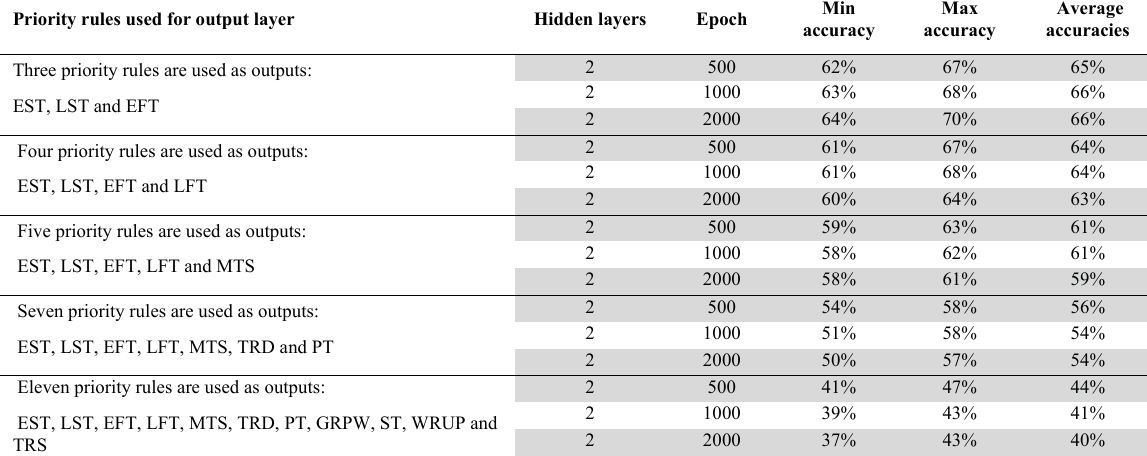
Training performance of developed MLFNN with two hidden layers Priority rules used for output layer Hidden layers Epoch